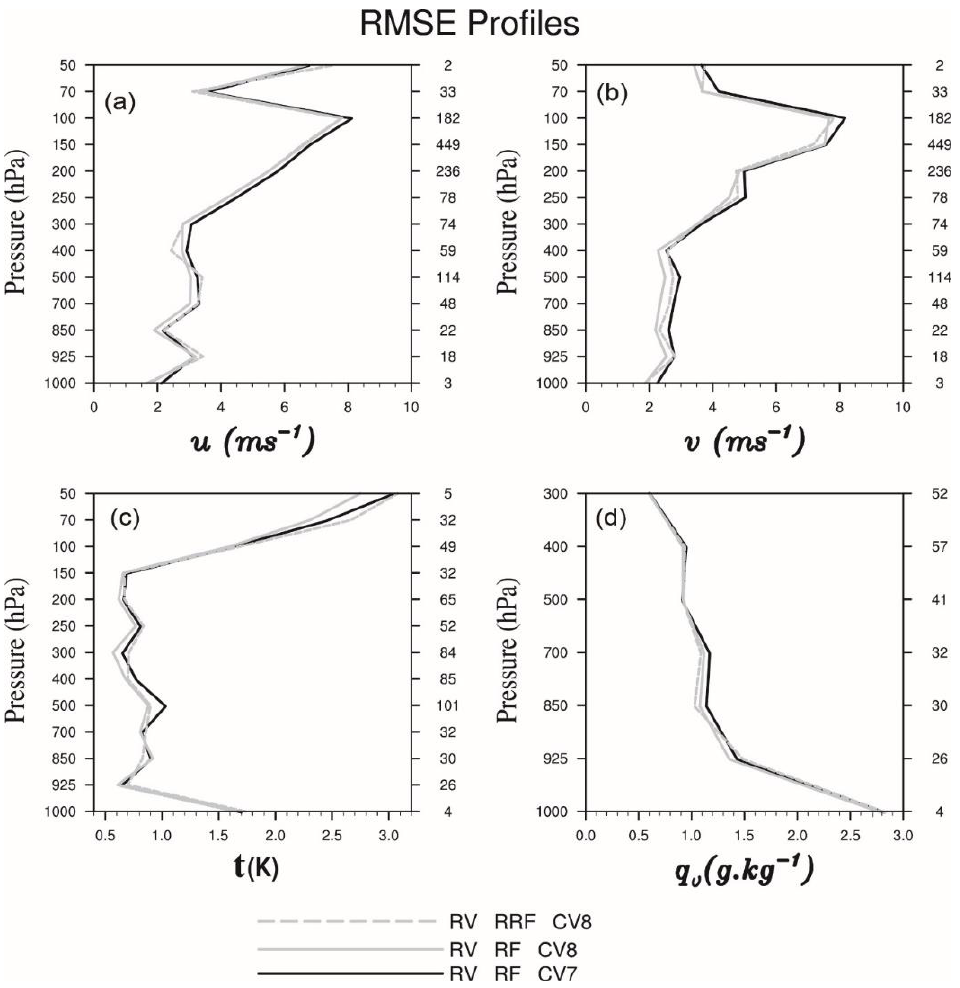
Figure 7. The root mean square error (RMSE) of vertical profiles of analyses versus conventional observations for ( a ) u-wind, ( b ) v-wind, ( c ) t—temperature, and ( d ) q vapor for RV_RF_CV7, RV_RF_CV8, and RV_RRF_CV8, respectively, at 0000 UTC 22 July 2010.